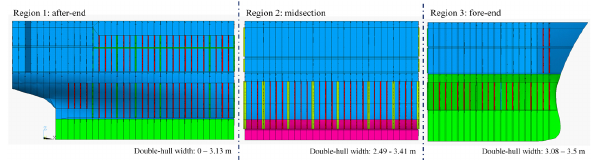
Figure 3: The denoted regions on the full-scale model of the struck ship. Size of double hull on each region is highlighted on lower part of the side